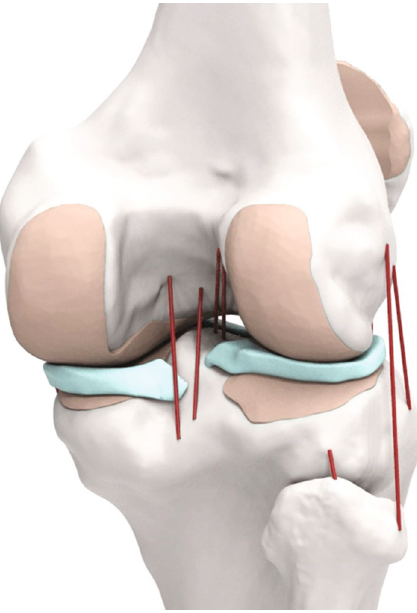
Figure 3: Validated FE native knee model used in this study, including TF and PF joints and major ligaments.